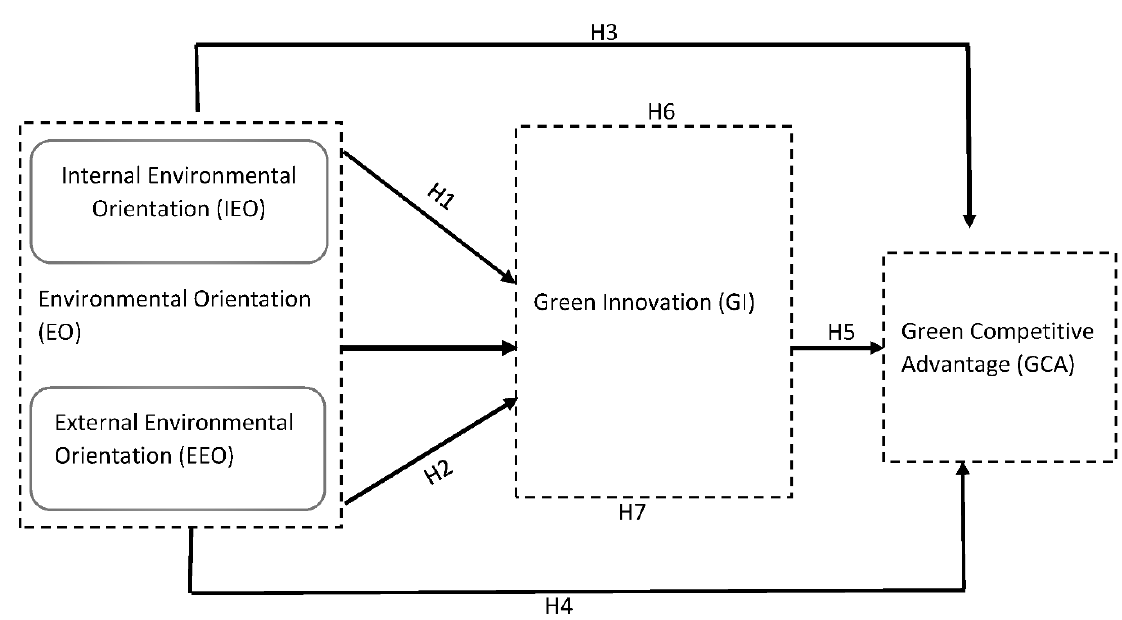
Figure 1. Conceptual model.